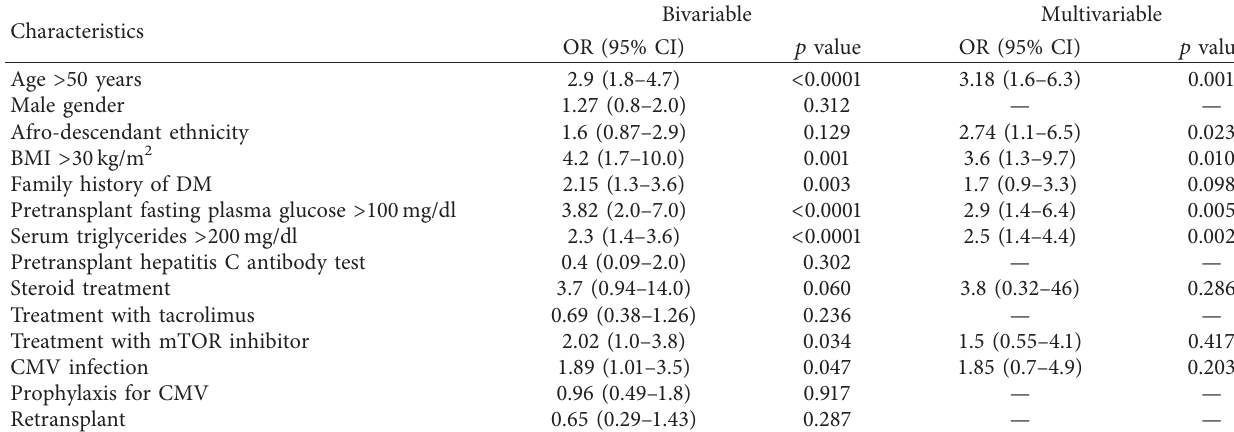
Table 3: Bivariable and multivariable analyses for risk factors associated with NODAT in patients with renal transplantation between 1995 and